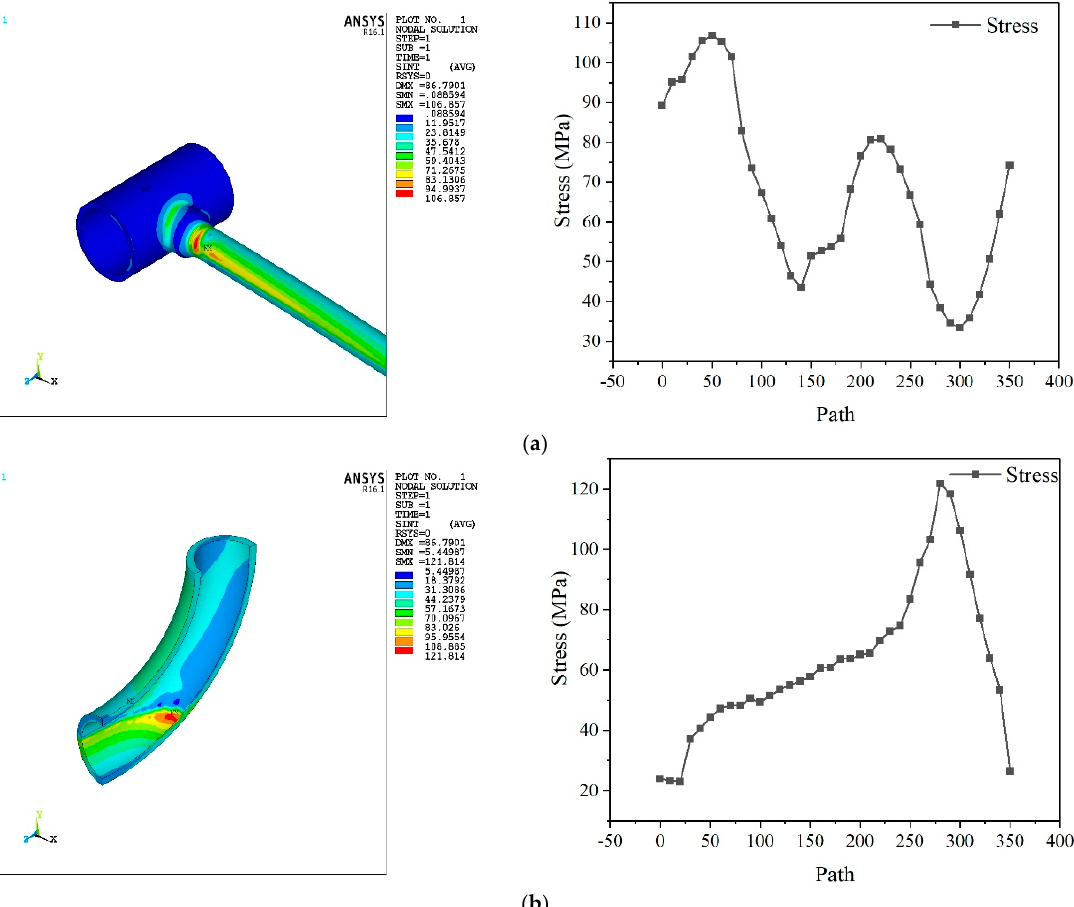
Figure 11. Stress distribution in Section A and B. ( a ) Section A. ( b ) Section